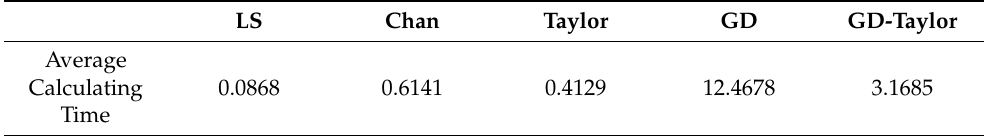
Table 4. Average calculation time using different